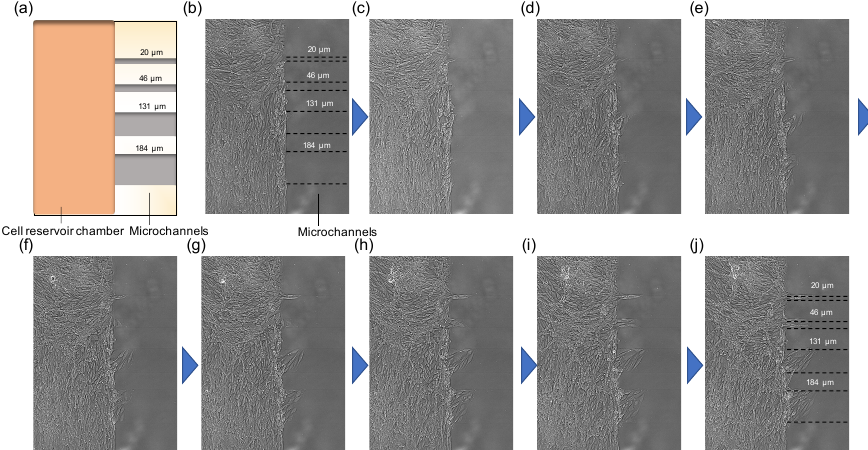
Figure 3. Time course images of collective migration of epithelial cells into the newly formed microchannels. ( a ) is the schematic drawing of the agarose micropatterns fabricated on the cultivation dish. Each 10 frame intervals of the supplement 10 min time-lapse movie is picked up from ( b – j ). ( b ) a micrograph just after microchannels fabricated using photothermal etching of focused IR laser; ( j ) 900 min later. Bars: